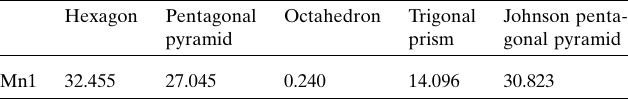
Table 3 Continuous shape measurement (CShM) values ( SHAPE 2.1 ; Llunell et al. , 2013) for the six-coordinate manganese(II)